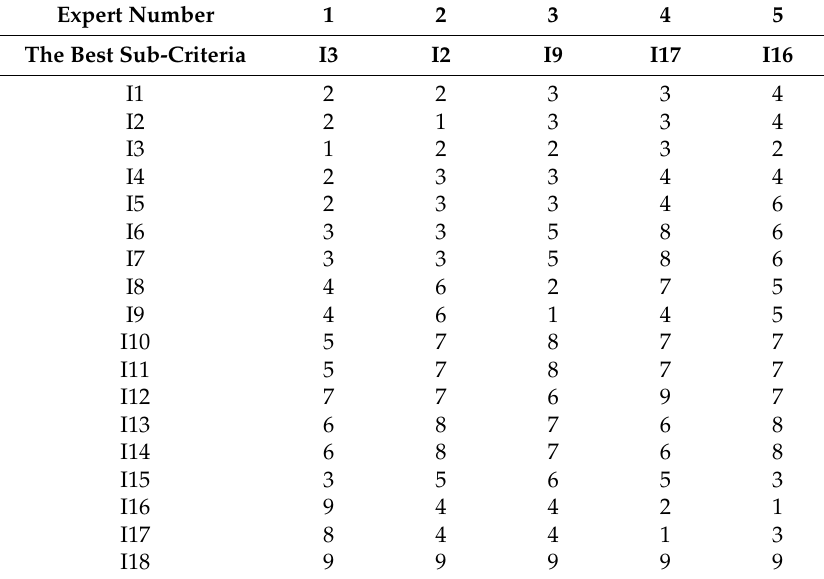
Table 8. The significant degree between the best sub-criterion and others. Expert Number